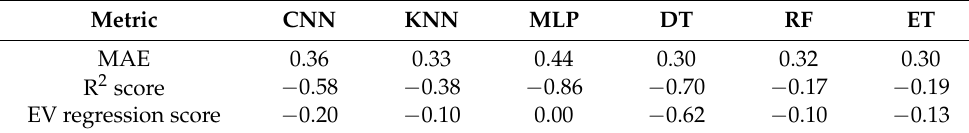
Table 12. Evaluation metrics for test set on phase-only image dataset.